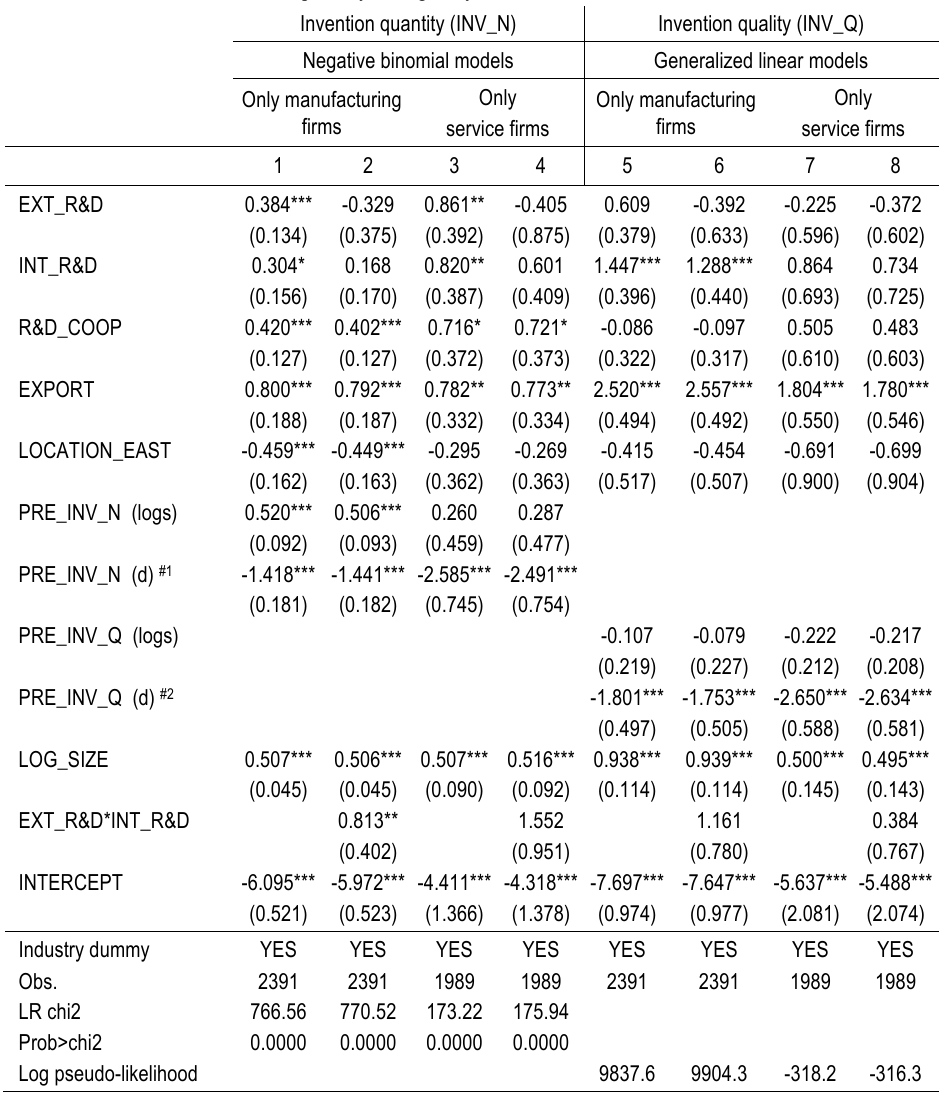
Table 6. Results for invention quantity and